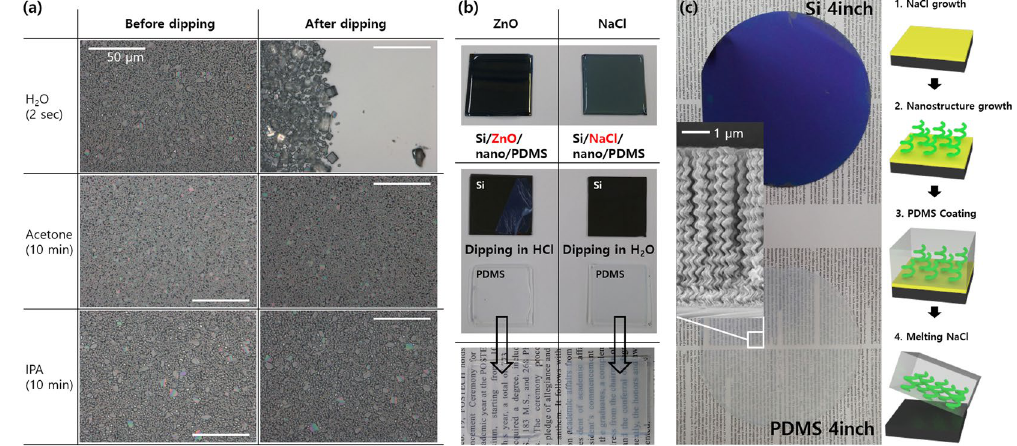
Figure 5. ( a ) Optical microscopy images of 500-nm-thick NaCl films before (left) and after (right) dipping in DI water, acetone, and IPA. ( b ) Photographs showing the transfer of WO 3 on PDMS using ZnO (HCl solvent) and NaCl (water solvent) as the sacrificial layer. ( c ) Photographs and schematics showing the transfer of WO 3 nanostructures from 4-inch Si wafer to PDMS using NaCl as the sacrificial layer. Inset is SEM images of WO 3